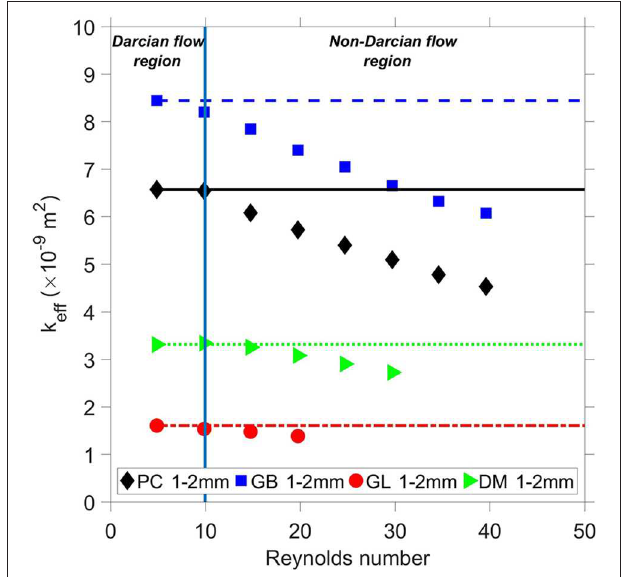
FIGURE 14 | Effective permeability (k eff ) as a function of Reynolds number. PC, pine chips; GB, gum bark; GL, gum leaf; DM, decomposing